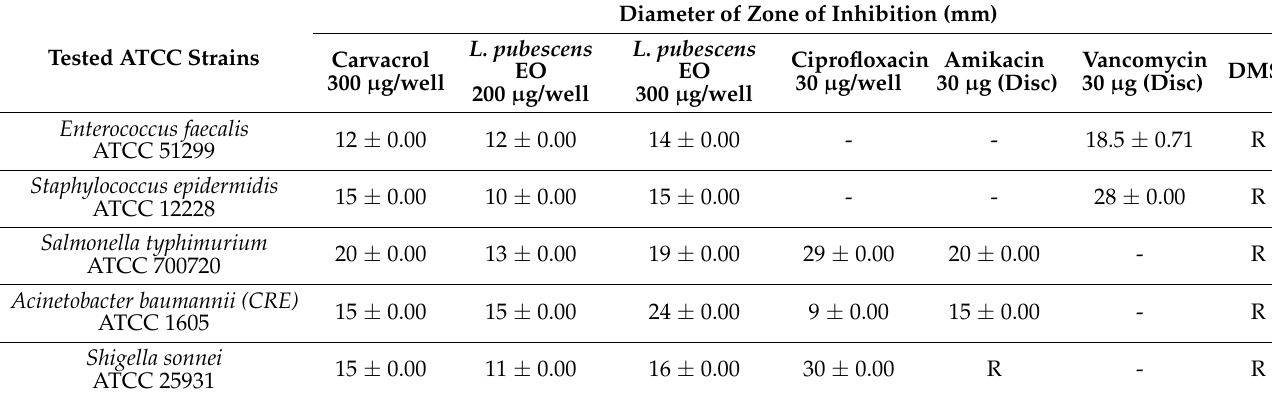
Table 3. Antimicrobial evaluation of carvacrol in dimethyl sulfoxide (DMSO) 10% w/v and L. pubescens EO in DMSO 10% v/v in agar diffusion assay. R = Resistant. Data expressed as (mean ± SD) of two replicates.